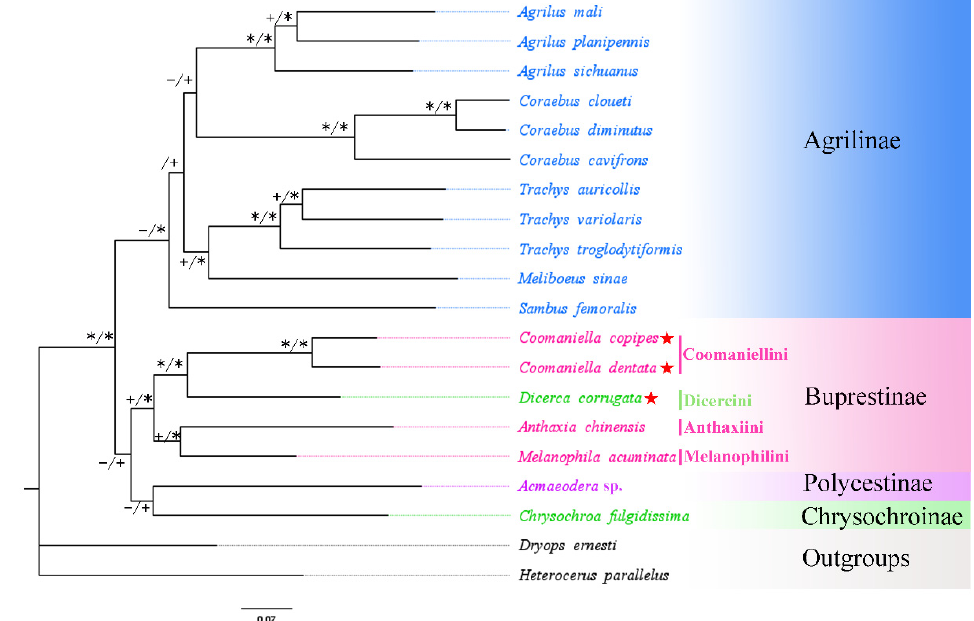
Figure 10. Phylogenetic relationships of 18 selected buprestid species inferred based on maximum-likelihood and Bayesian analyses of 13 protein-coding genes and two rRNA genes. * ML bootstrap = 100 or posterior probabilities = 1; + ML bootstrap ≥ 50 or posterior probabilities ≥ 0.5; − ML bootstrap < 50 or posterior probabilities < 0.5. Red star: means species which are newly sequenced in this study.